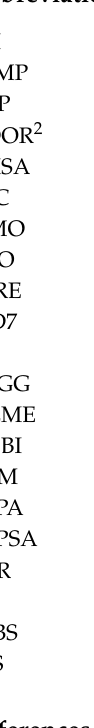
Table S1: EMSA quantification data, Table S2: GEO2R analysis of expression profiles from TTHB099-deficient and wild type T. thermophilus HB8 strains, Table S3: Oligonucleotides, Figure S1: Quantitative densitometry analysis of TTHB099 binding to its palindromic consensus sequence, Figure S2: Expression, purification, and quantification of TTHB099 protein, Data S1: REPSA Round 7 fastq sequences, and Data S2: REPSA Round 7